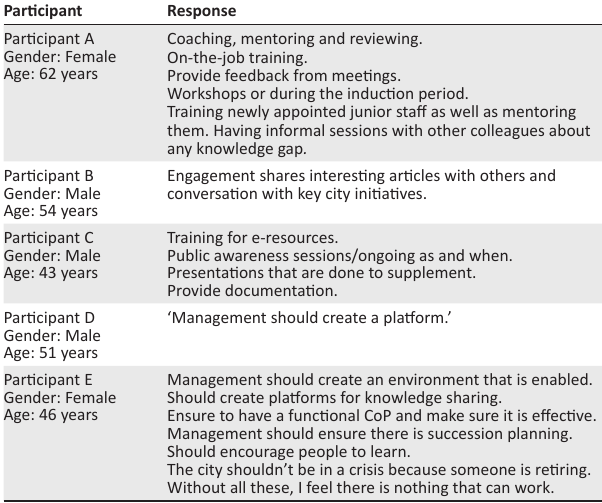
TABLE 4: The role of management in tacit knowledge sharing at the City of Johannesburg Library and Information Services.